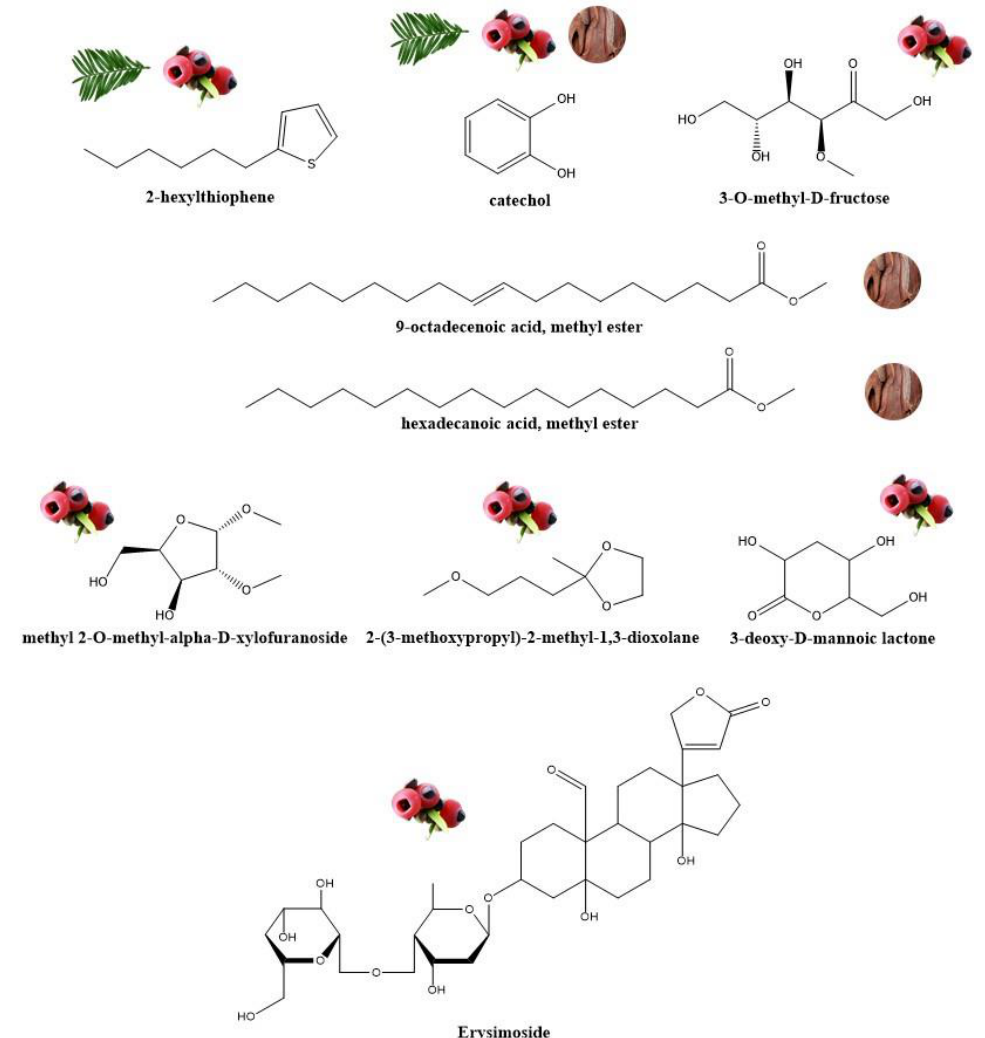
Figure 1. Main phytochemicals identified in Taxus baccata extracts by GC – MS. Pictograms indicate the organ of the plant in whose extract the compound is present. Table 2. Minimum inhibitory concentrations of Taxus baccata extracts against several soft rot Pectobac- teriaceae (SRP) taxa, expressed in µ g · mL − 1 . Bacteria Fruit Extract Bark Extract Leaf Extract P. carotovorum subsp.